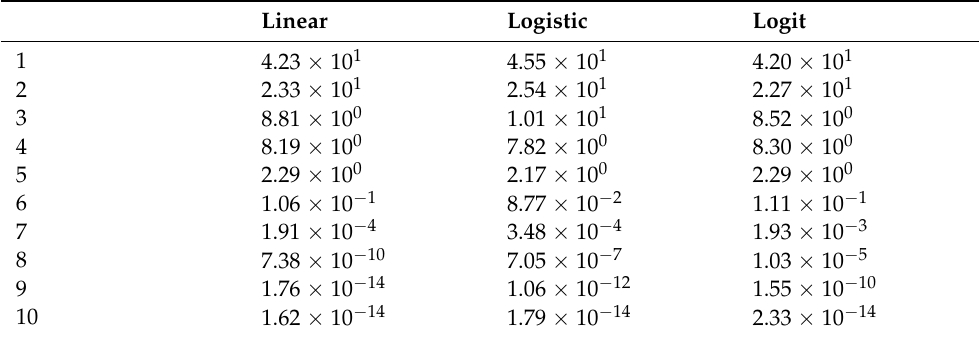
Table 1. The evolution of